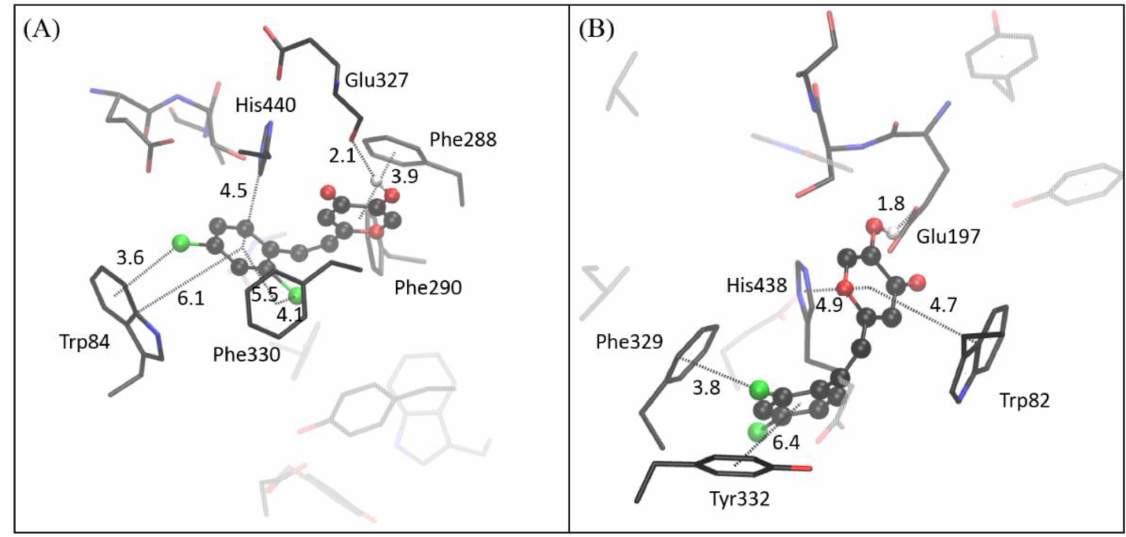
Figure 10. The complex obtained by docking cis - 4 into the active site of AChE ( A ), and by docking cis - 4 into the active site of BChE ( B ). Hydrogens omitted for